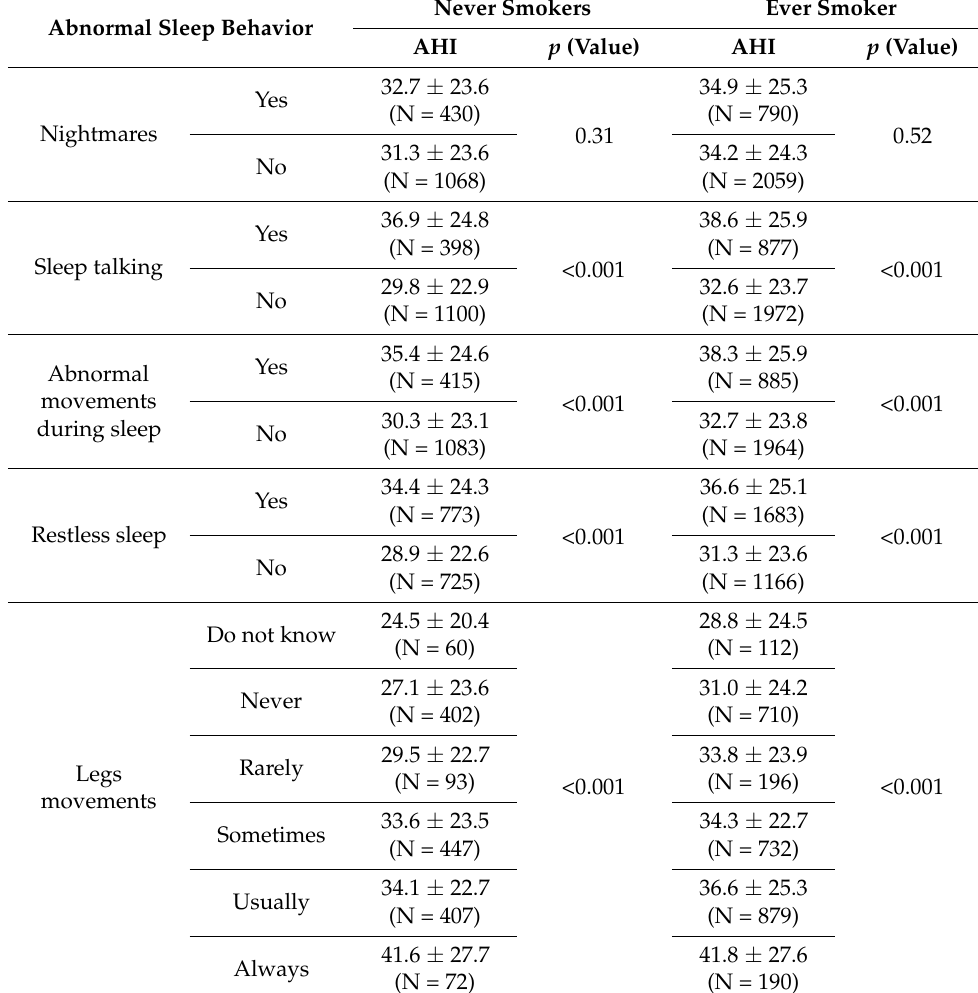
Table 6. Comparison of AHI and abnormal sleep behaviors according to smoking